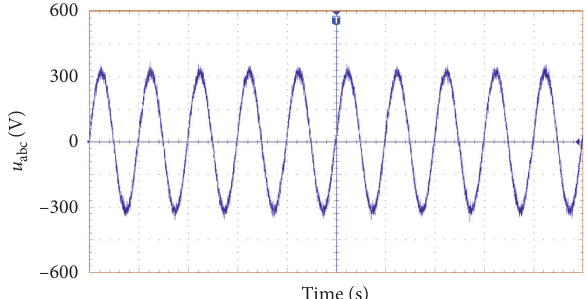
Figure 16: Experimental voltage waveform of the ESS (output power is set to 40kW).